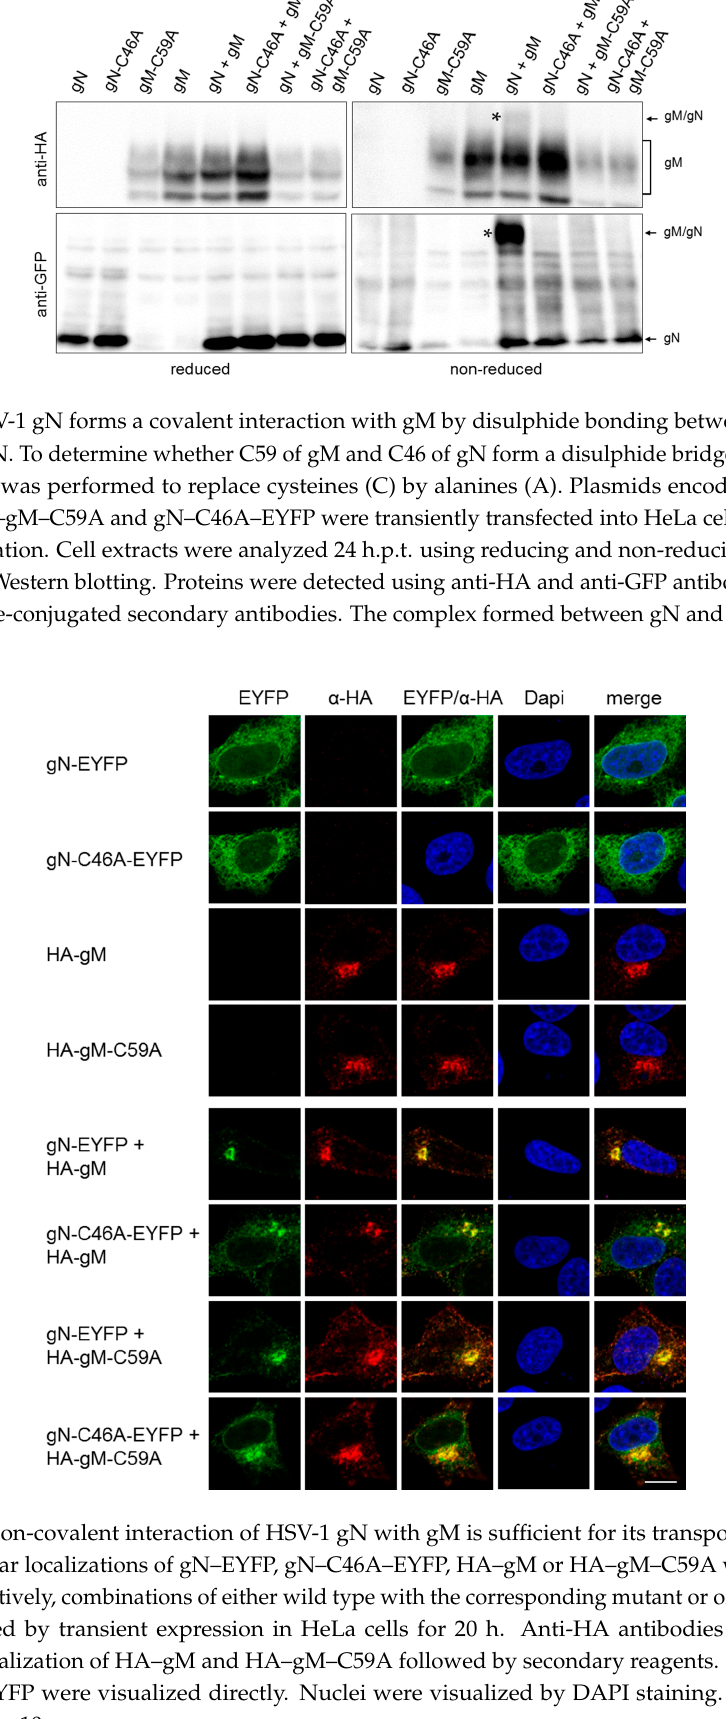
corresponds to 10 µ